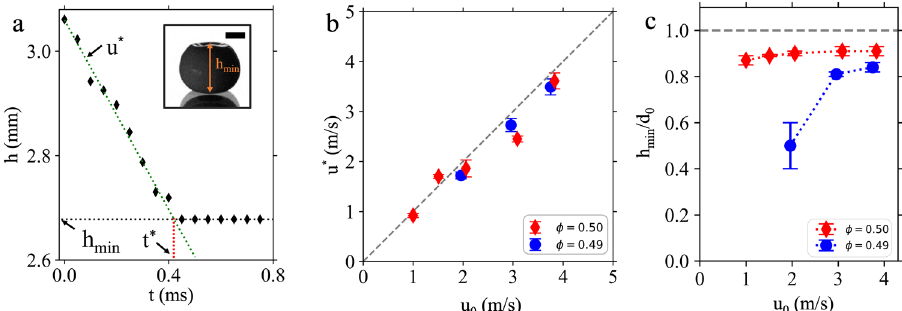
Fig. 5 Characterisation of the partial solidi fi cation regime. a Height of the drop apex from the impact substrate, plotted against time, for ϕ = 0.50, u 0 = 3 m / s . h decreases at the speed u * until time t * , then plateaus at the value h min . Inset: post-impact snapshot of a drop at the minimum height h min . Scale bar in the inset is 1mm. b h decreases at a speed identical to the impact velocity, indicating that over the timescale t * , the top portion of the drop is unaffected by the impact event. u * is computed as the slope of the linear fi t to the decreasing part of h vs. t data, error bars indicating the standard deviation over at least 5 trials. Dashed line corresponds to u * = u 0 . c h min / d 0 vs. impact velocity u 0 . h min / d 0 increases with increasing impact velocity, and then plateaus at a value less than 1, indicating fi nite compression of the drop along impact axis. Dashed line indicates h min / d 0 = 1. Error bars indicate one standard deviation over at least 5